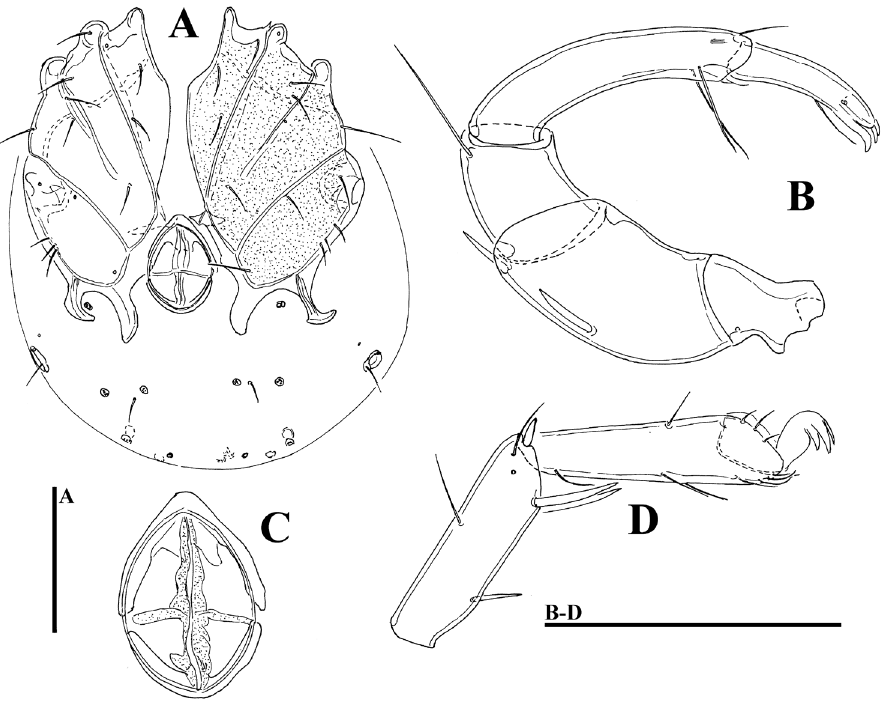
Figure 4. Litarachna sp., female, Rio Grande: A idiosoma, ventral view B palp C genital field D I-L-5 and -6. Scale bars = 100